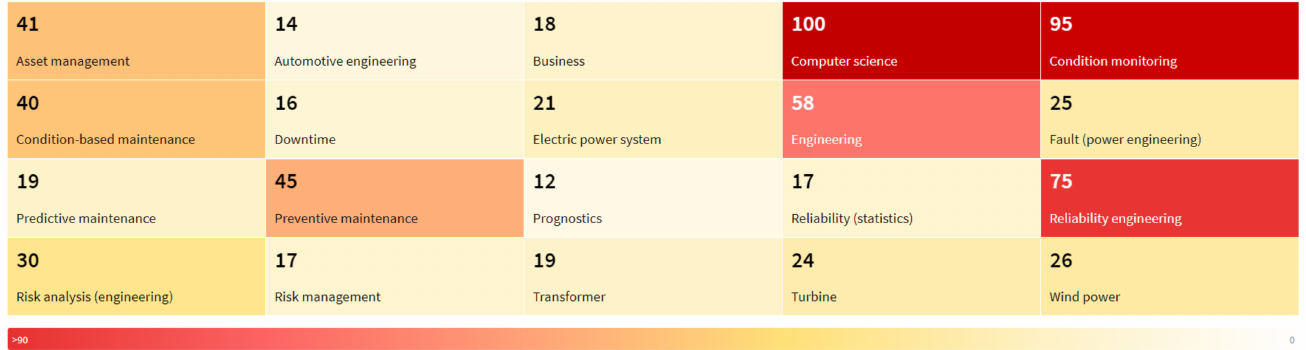
Figure 7. Top 20 most frequent Fields of study in papers of The Lens. Among them, the most prominent FoS are: “Computer science”; “Wind power”; “Turbine”; “Predictive maintenance”; “Transformer”; “Electric power system”; etc. Likewise, the heat map of the top 20 most-frequent subjects is presented in Figure